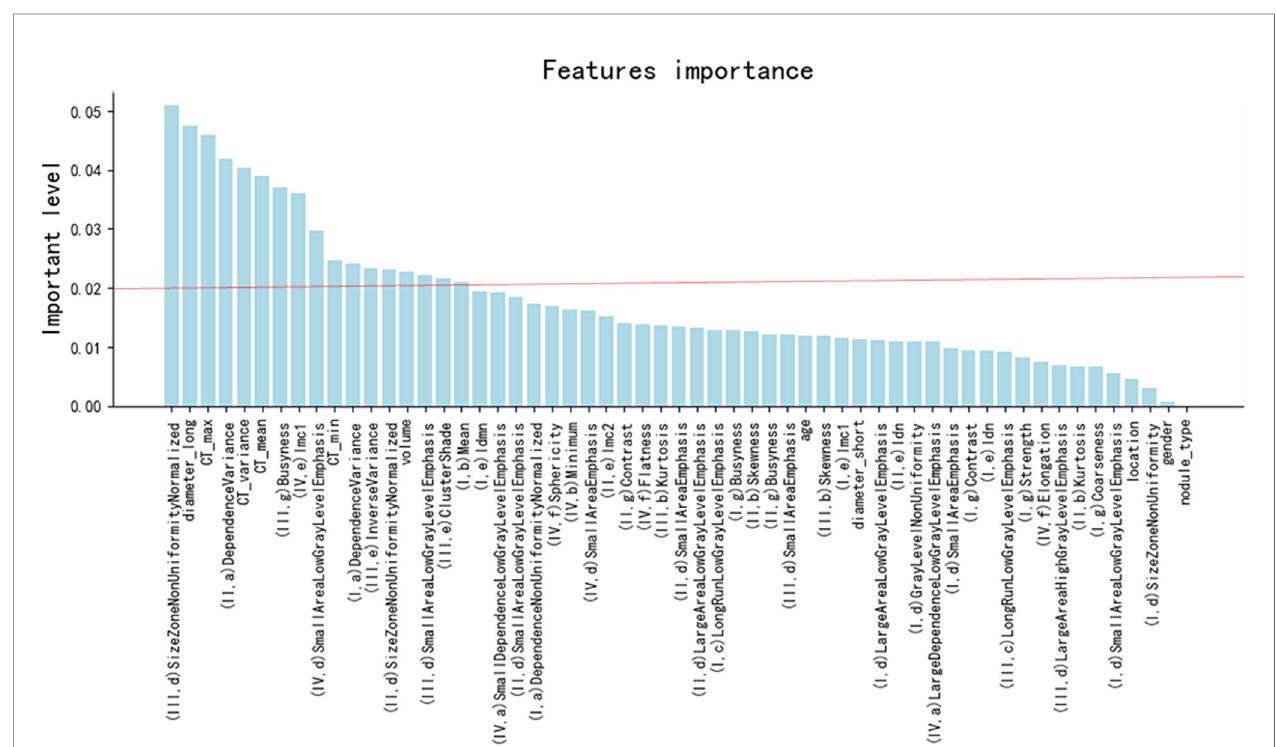
FIGURE 2 | The order of the importance level of the radiomics features and clinical features. I: the fi lter of log_sigma_5_0_mm, II: the fi lter of log_sigma_4_0_mm, III: the fi lter of log_sigma_3_0_mm, IV: from original pictures. a: Gray Level Dependence Matrix features, b: First-Order features, c: Gray Level Run Length Matrix features, d: Gray Level Size Zone Matrix features, e: Gray Level Co-occurrence Matrix feature, f: Shape features, g: Neighboring Gray Tone Difference Matrix features. CT_max, CT_variance, CT_mean, and CT_min indicate maximum CT value, variance of CT value, mean CT value, and minimum CT value, respectively.